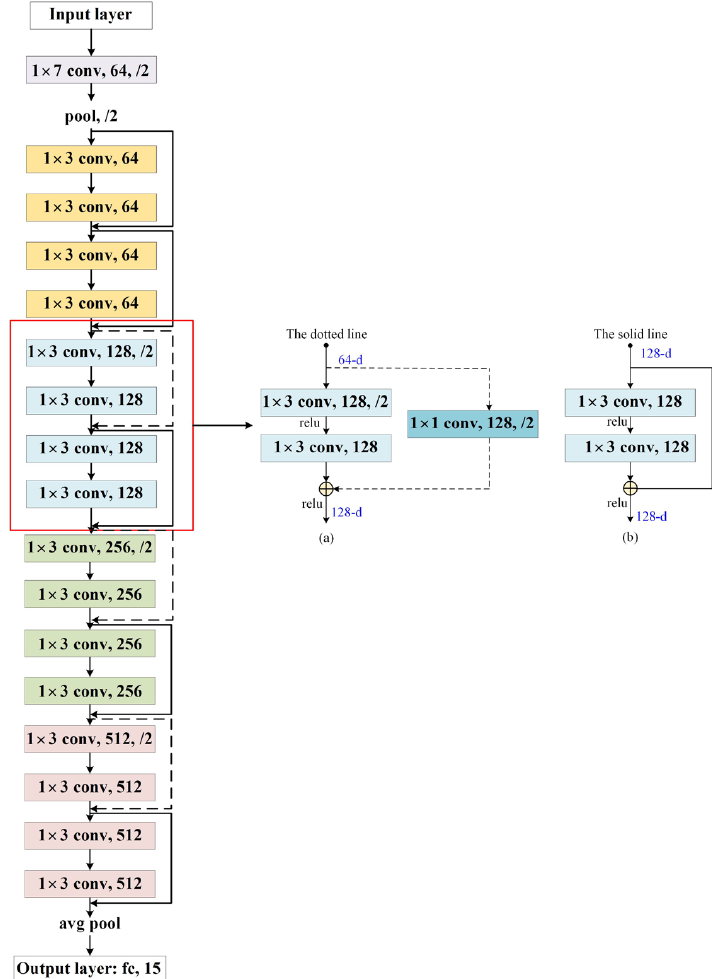
Figure 9. The neural network structure of the modified ResNet-18. (a) The concrete structure of the dotted line; (b) The concrete structure of the solid line.